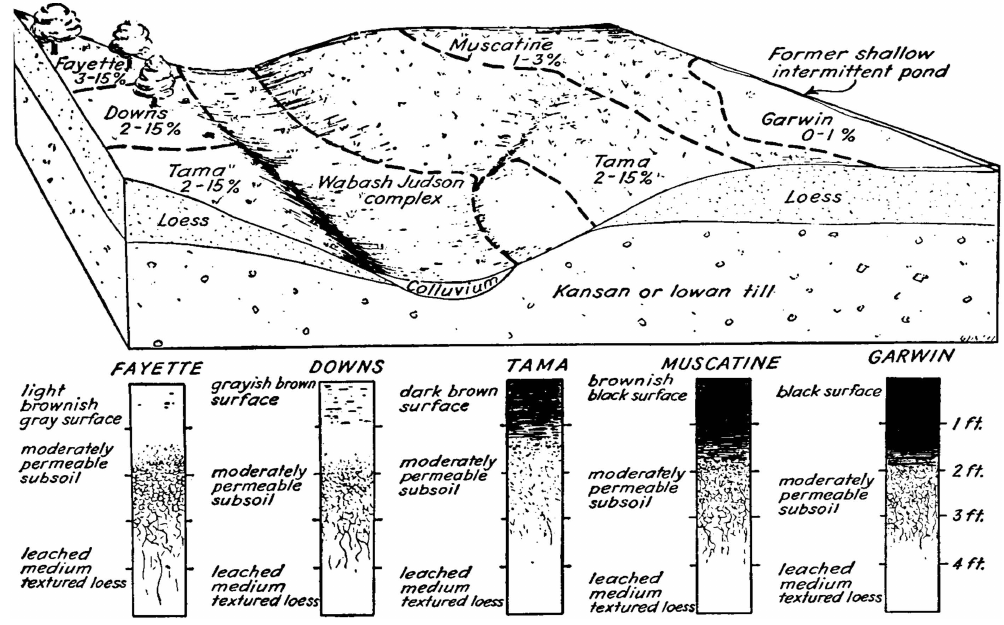
Fig. 1. Block diagram of soils in an Iowa catchment, USA, showing characteristic differences of soil types on the plateaus, the slopes and the valleys and demonstrating the importance of the soil forming factors parent material and